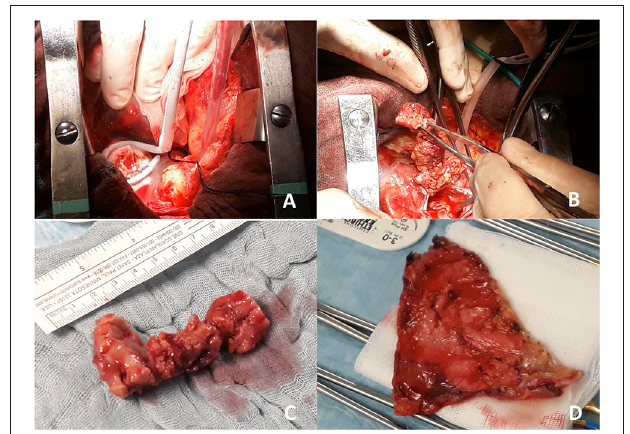
FIGURE 3 | Intraoperative view of residual mass freezing ( A and Supplementary Video 1 ) and removal of superior cava vein mass ( B and Supplementary Video 2 ). In (C) , gross surgical pathology of the removed mass (7cm length) is shown, while in (D) , infiltrated pericardium is shown after pericardiectomy.